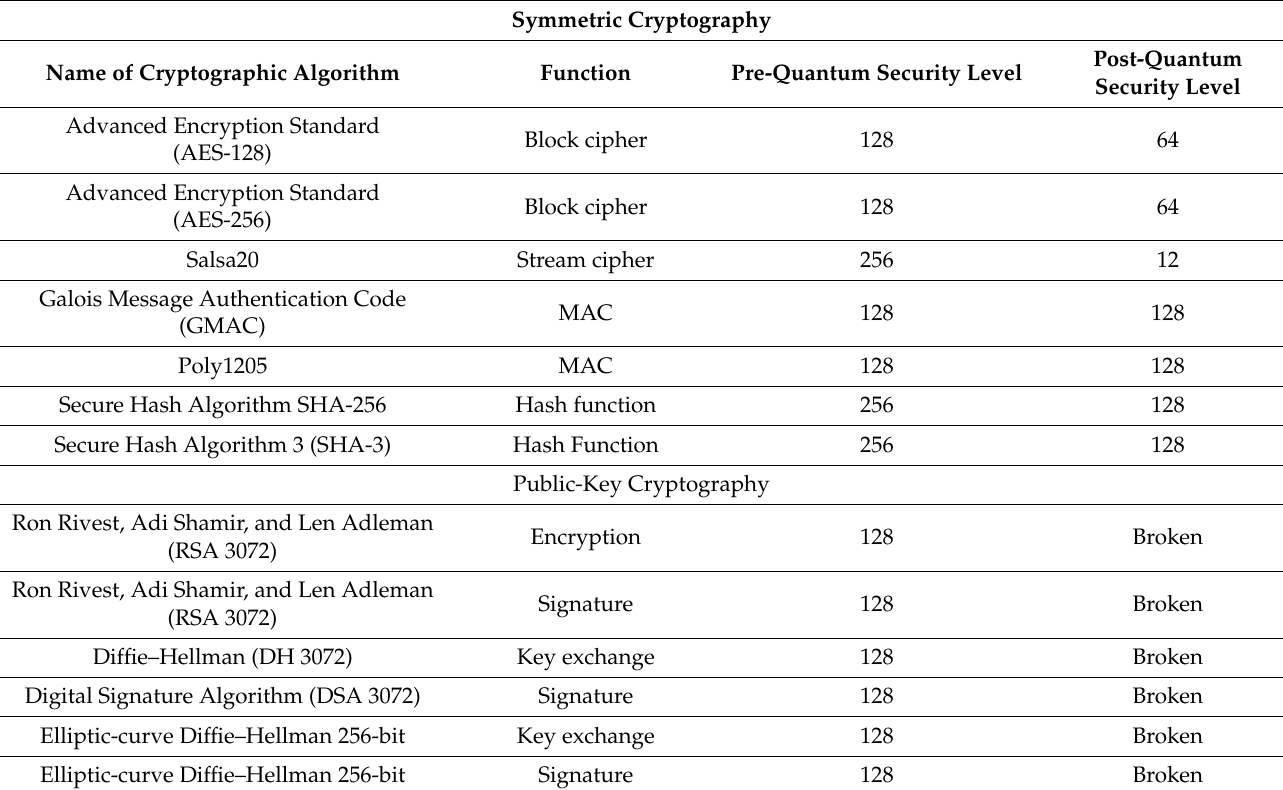
Table 3. Impact of quantum computing on standard cryptographic algorithms. Symmetric